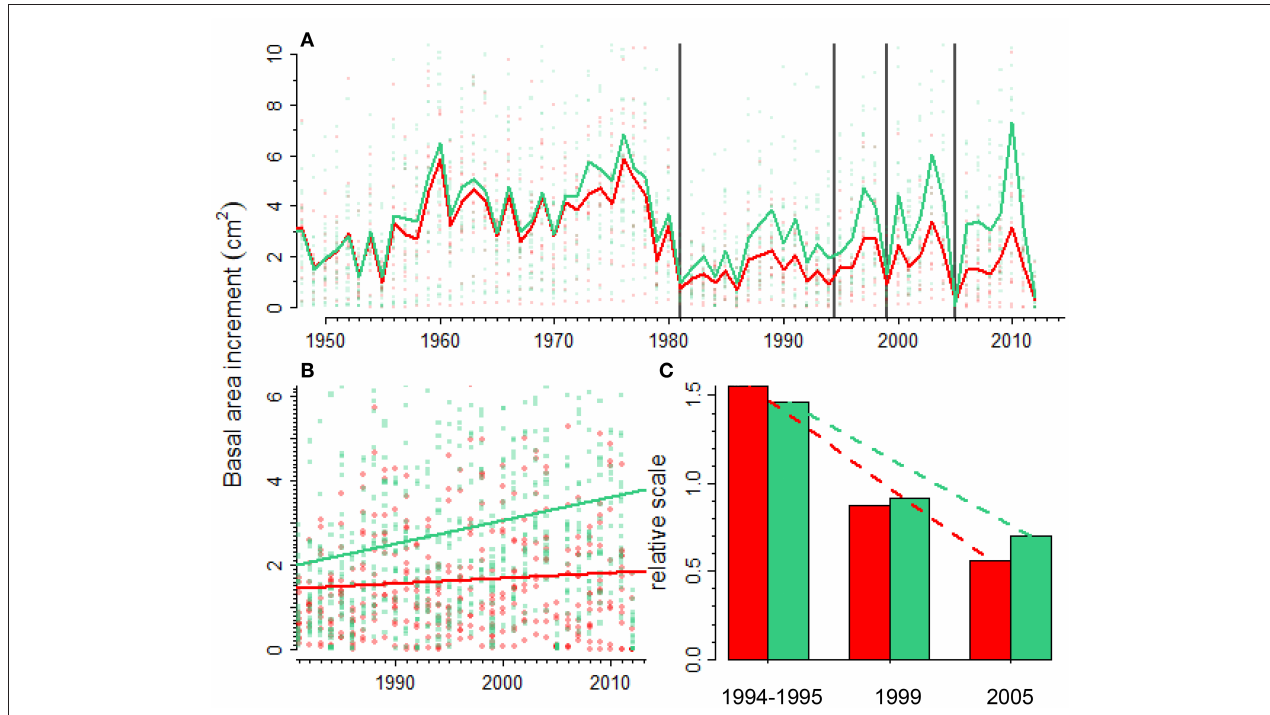
FIGURE 4 | Scots pine growth responses to recurrent droughts (vertical lines). Forest growth (A) is quantified as basal area increment (BAI) and it was reconstructed for declining (red line and symbols) and non-declining (green line and symbols) Scots pine individuals in a forest showing drought-triggered die-off. The difference in BAI between declining and non-declining individuals increases with time since 1980 onwards (B) pointing to the existence of legacy effects on declining individuals. The last figure (C) shows relative growth values (ratio between post- and pre-drought BAI values) for the three most important recent droughts (1994–1995, 1999, and 2005) in declining (red bars) and non-declining (green bars)